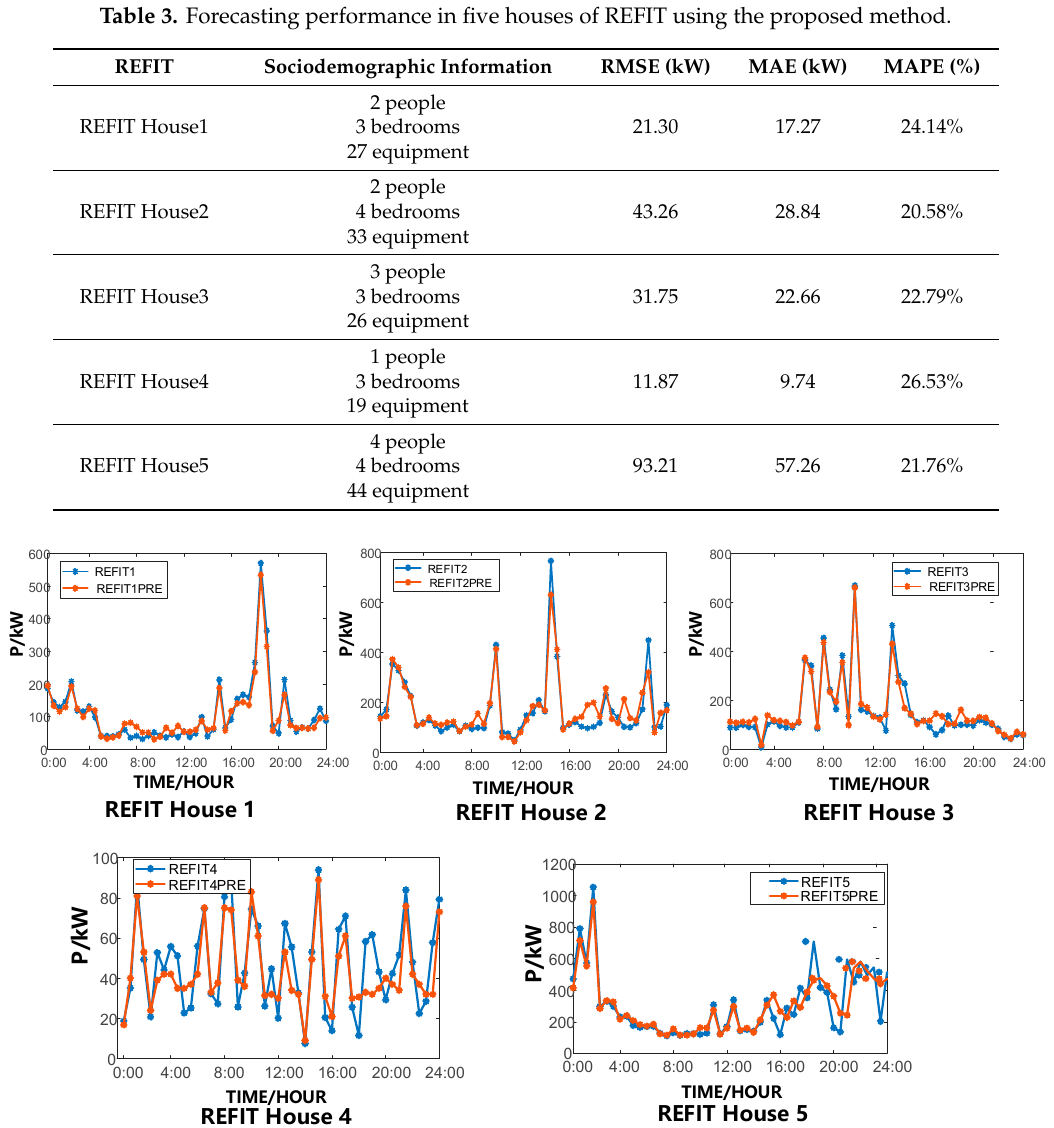
Figure 11. Actual (blue) and forecasted load profiles (red) throughout a day for the leading scenarios in five households from REFIT dataset.